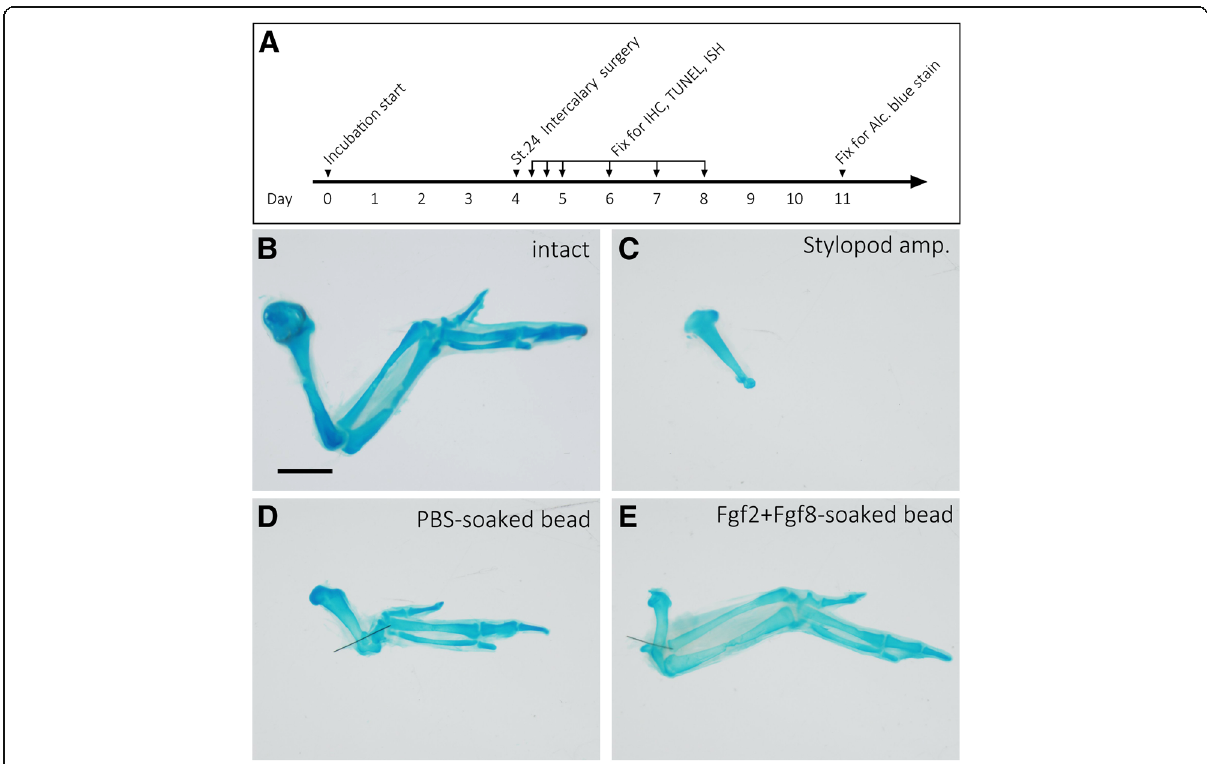
Fig. 2 The skeletal phenotypes. a Time schedule of the experiment. b The intact chicken wing. c The skeletal pattern derived from the amputated limb bud three-quarters from the distal tip at st. 24. d The skeletal pattern of the limb bud from which the middle part was dissected out. An